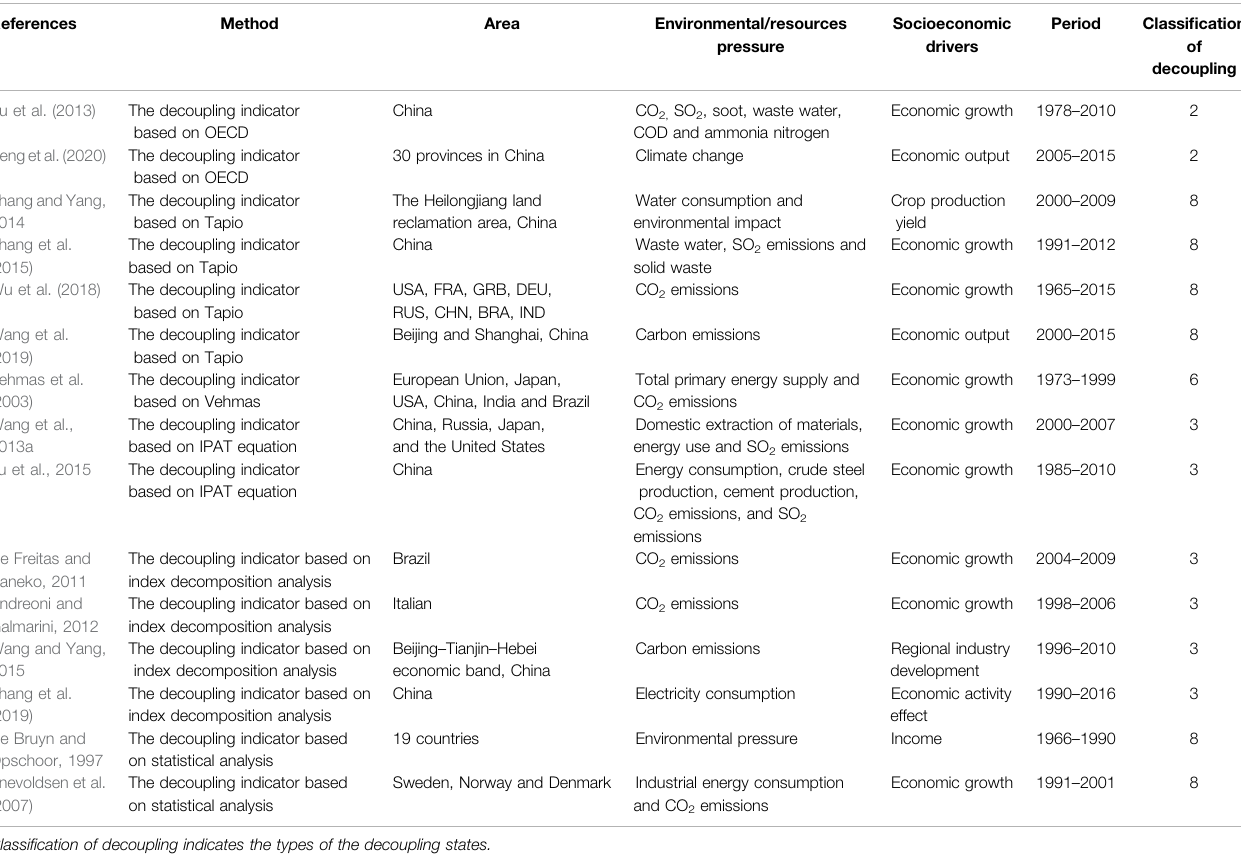
TABLE 2 | Comparison of different methods for measuring